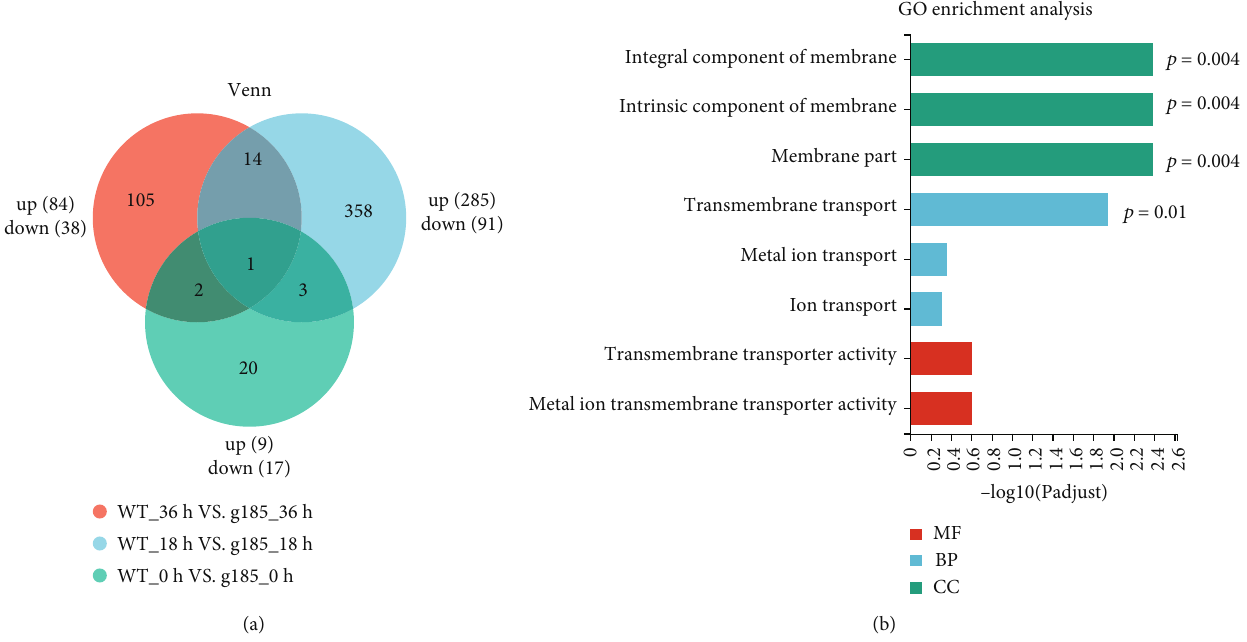
Figure 4: Transcriptome analysis reveals the role of Ao g185 in the regulation of cell transmembrane transport. (a) Venn diagram. (b) GO enrichment analysis. The GO enrichment analyses were conducted based on the DEGs identi fi ed at 18h. MF: molecular function; BP: biological process; CC: cellular